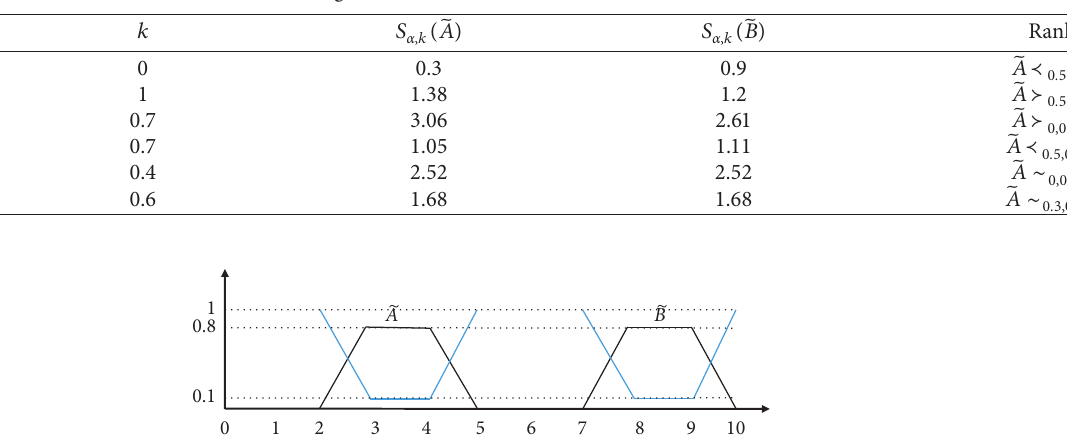
Figure 7: S index of two TraIFNs 􏽥 A and 􏽥 B . α ,k Table 3: Ranking results for some different amounts of α and k .